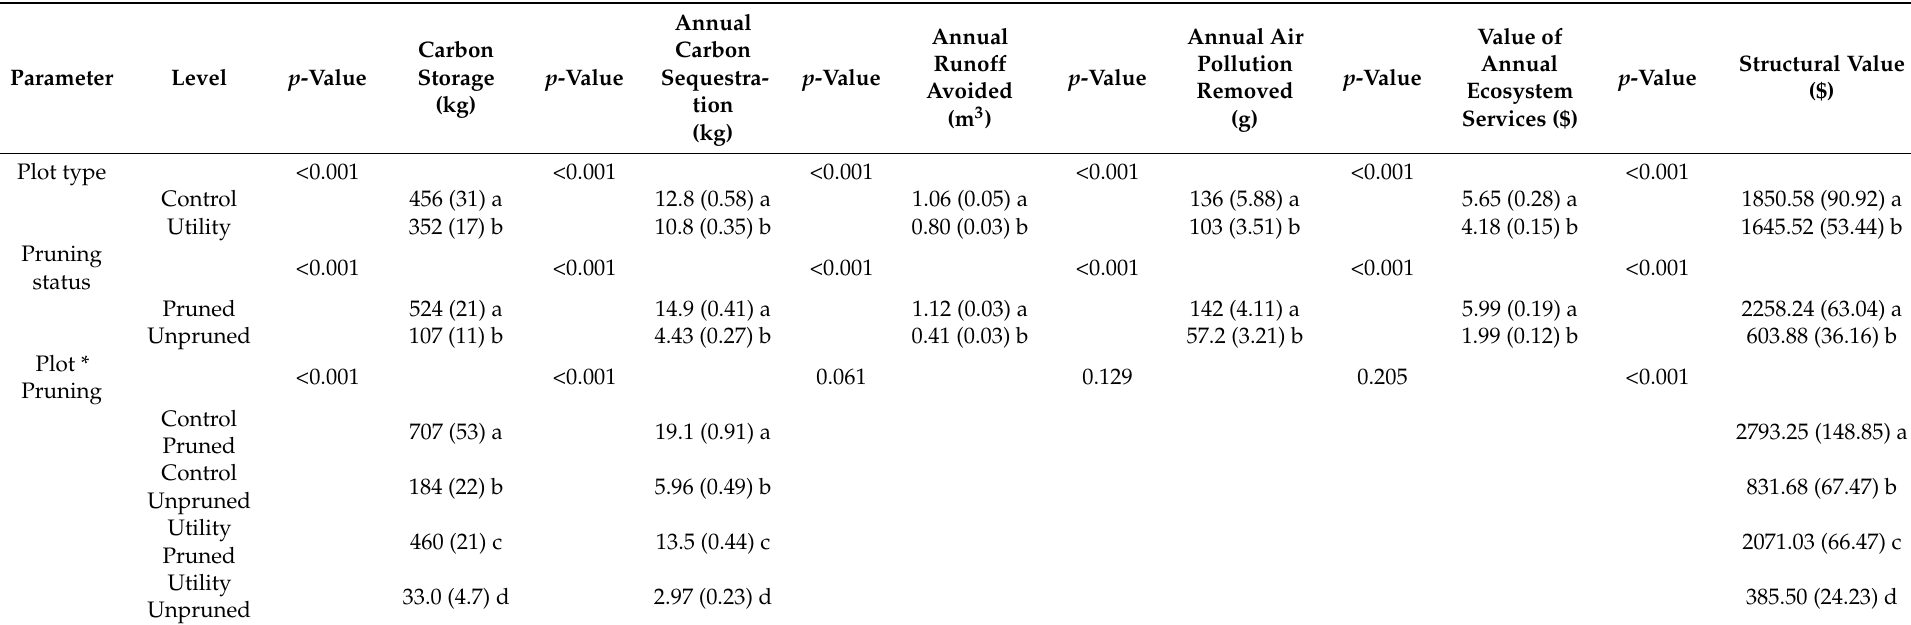
Table 2. Means (followed by standard error in parentheses) of i-Tree Eco output and p -values for comparisons between plot types, pruning status, and their interaction; within each effect or their interaction, means followed by the same letter are not significantly different ( p > 0.05) by Tukey’s Honestly Significant Difference